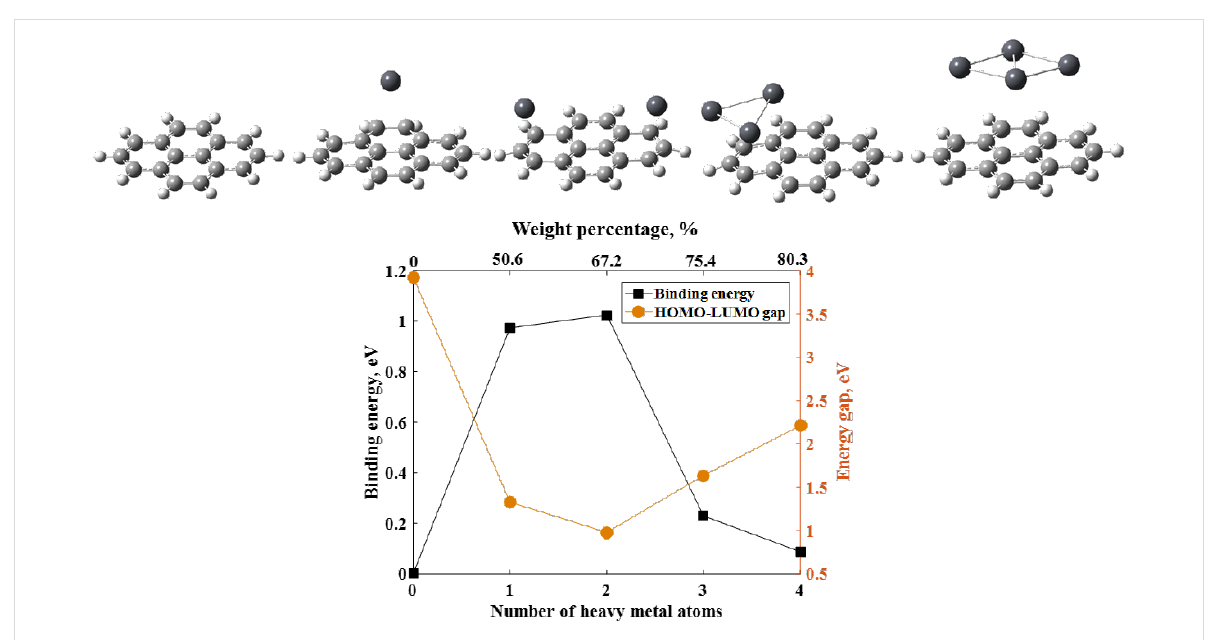
Figure 7: Dependence of the binding energy and HOMO-LUMO gap on number of Pb atoms. The top X axis represents the concentration of heavy metals atoms in weight percentage. The percent composition of a heavy metal atom in a system was calculated as a relationship between the total atomic weight of the Pb atoms and total weight of entire interacting systems (including graphene cluster and Pb atoms). Topmost panel shows the results of optimization obtained for different cases of adsorption of Pb atoms by the graphene